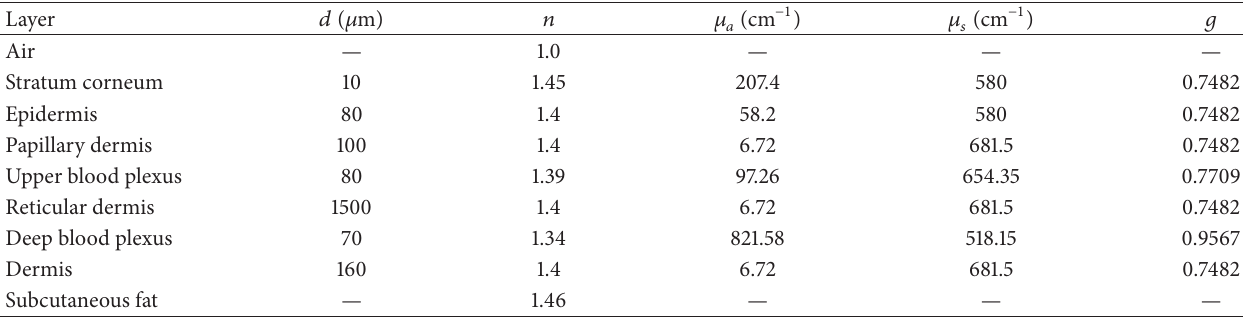
— — — Table 2: The optical parameters (𝜇 𝑎 ,𝜇 𝑠 ,𝑔,𝑛) at 442 nm of the eight-layer BCC skin optical model. Layer Air —